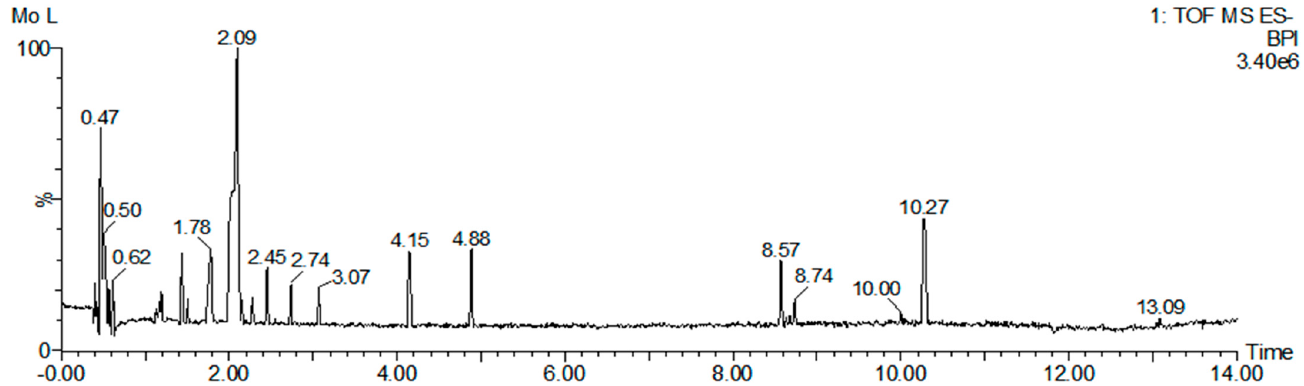
Figure 1. UPLC − QTOF − MS/MS analysis of M. concanensis L. Base peak intensity (BPI) chromato- gram. Table 1. Phytochemical profiling of M. concanensis Leaves.